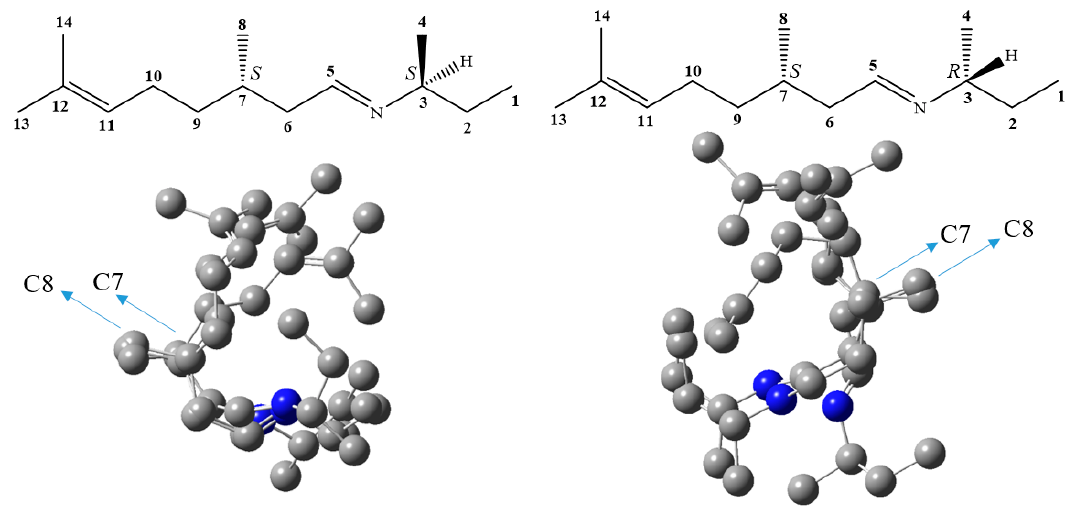
Figure 9. Superposition of the first three most stable conformers of the imines derived from sec - butylamine ( S,S and S,R diastereoisomers). Hydrogen was omitted for better